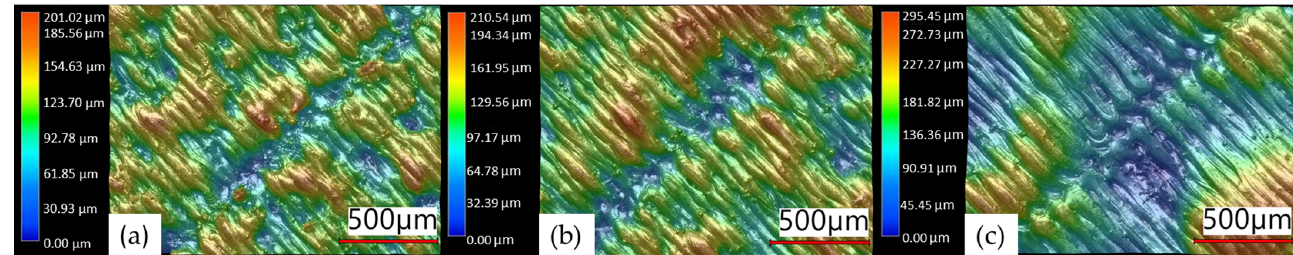
Figure 19. 3D Height maps of ( a ) low-LED test piece (0.23 J/mm), ( b ) reference LED test piece (0.33 J/mm) and ( c ) high-LED test piece (0.50 J/mm).